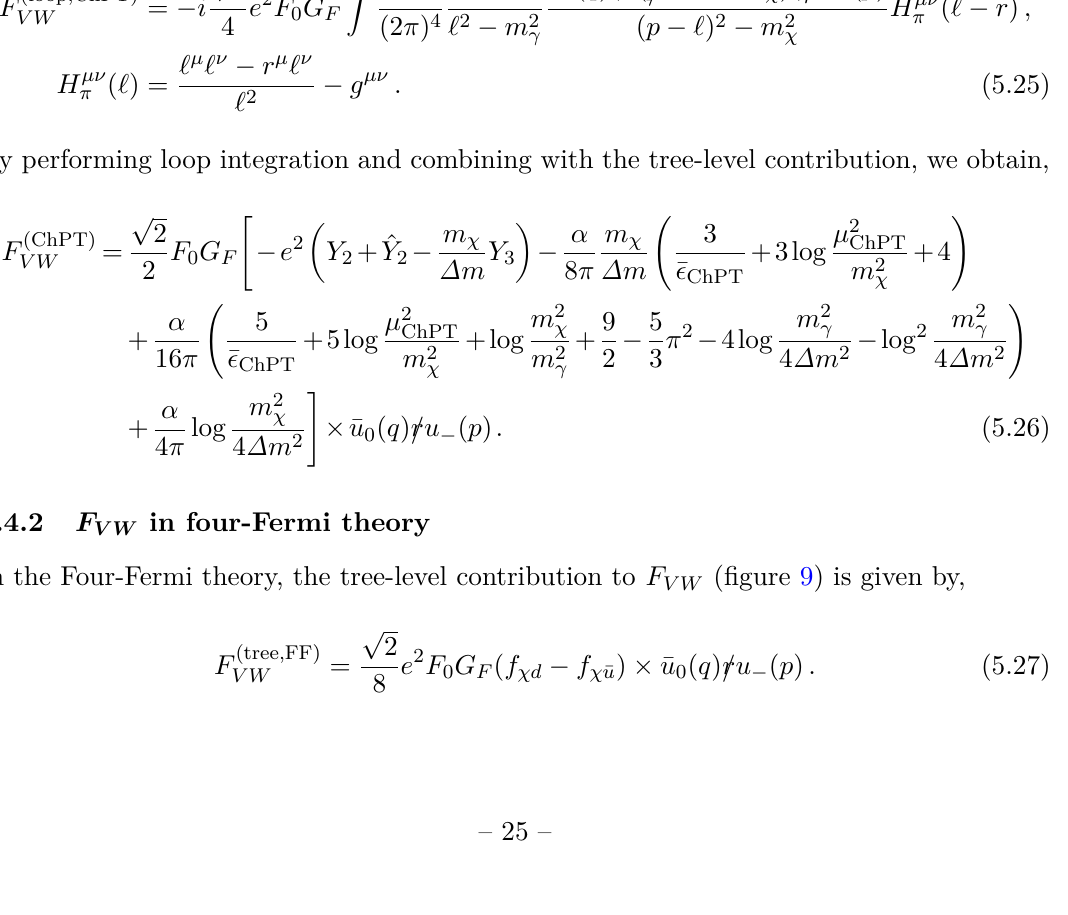
Figure 9 . The tree-level contribution to F V W in the Four-Fermi theory. The point (cid:4) vertice proportional to q 1